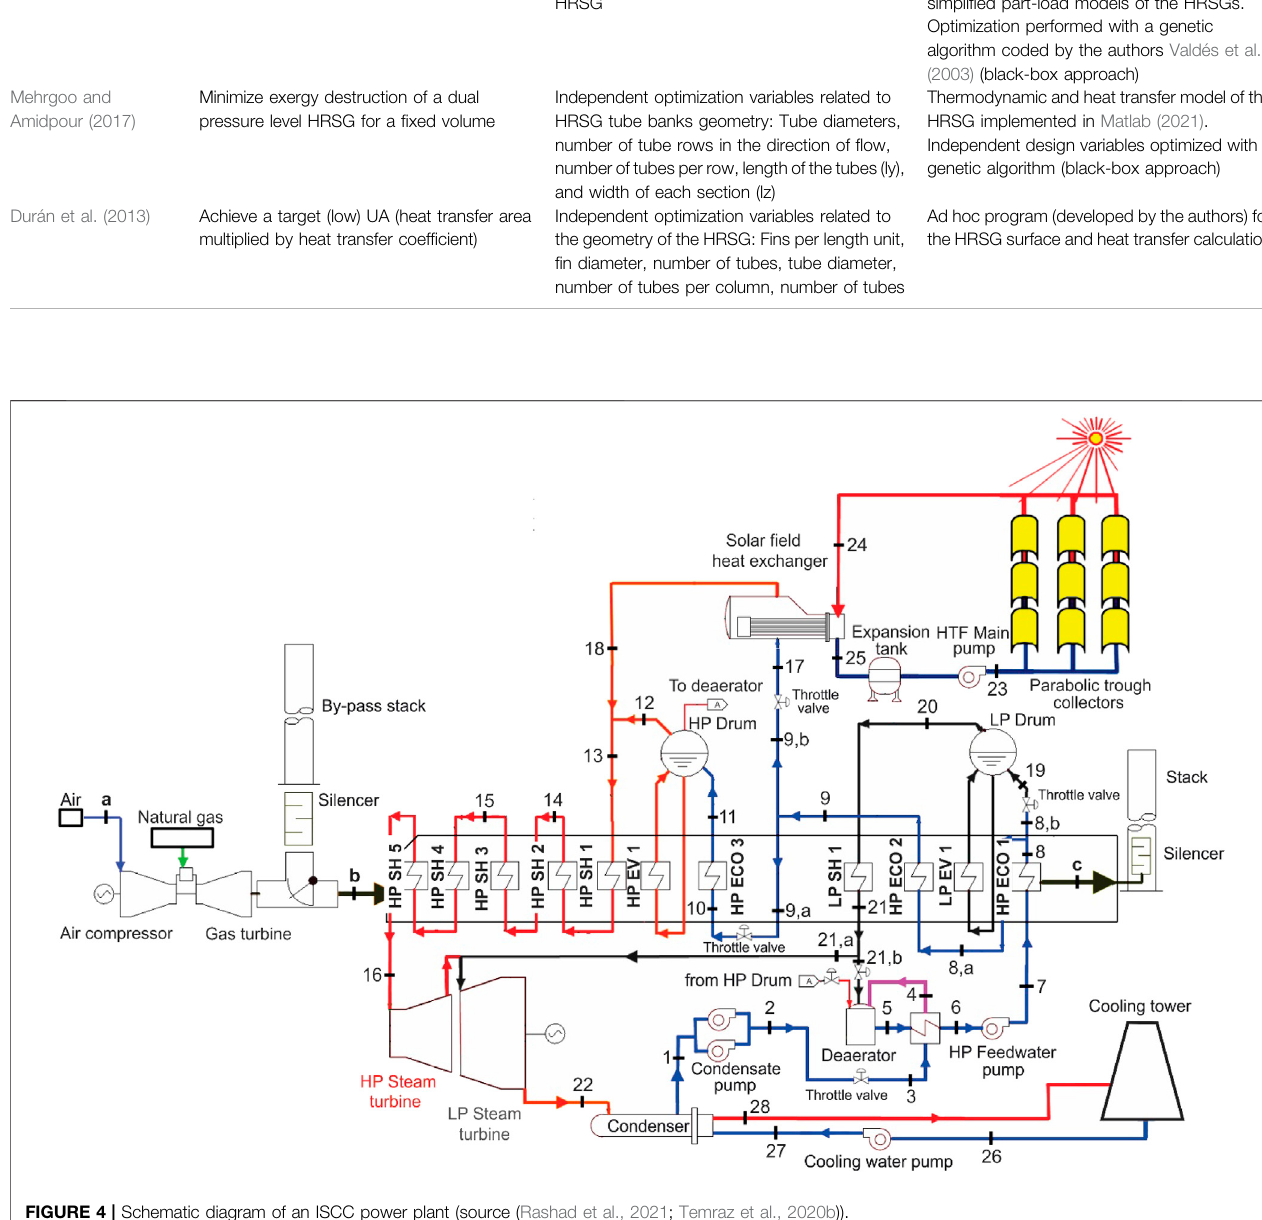
Frontiers in Energy Research |